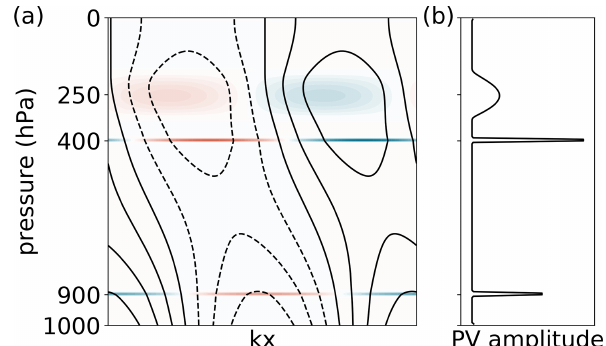
Figure 11. (a) Structure of interior PV (shading) and ψ (contours) for the most unstable mode of the default smooth experiment in- cluding latent heating and (b) amplitude of interior PV anomalies. Values are not comparable to physical values due to normalisation constraint mentioned in Sect.